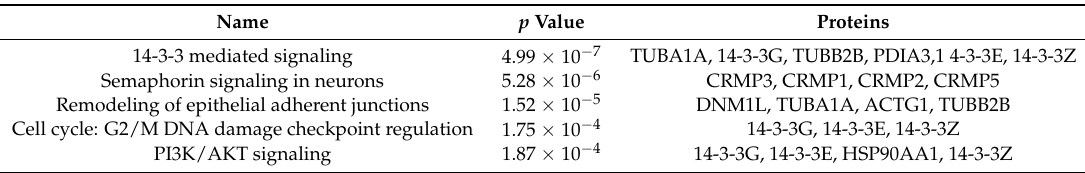
Table 2. Ingenuity top canonical pathways.